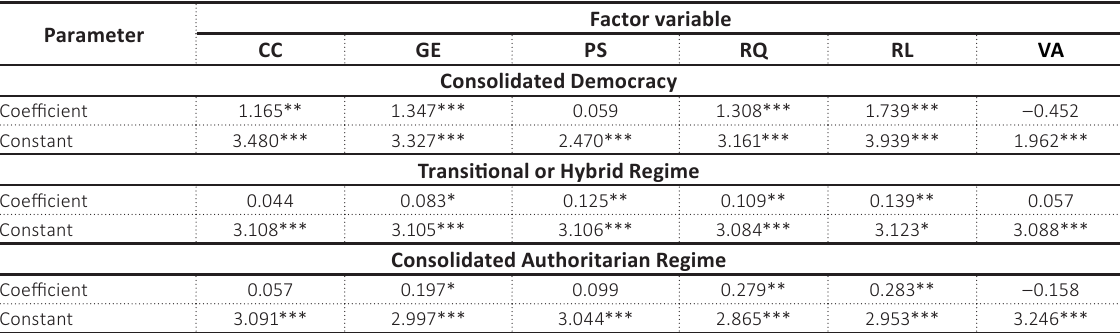
Table 6. The influence of governance quality on the level of independence of central banks among the countries with different political